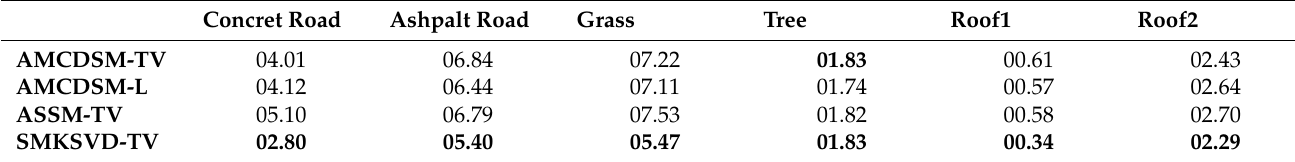
Table 11. HYDICE urban image: Commission errors of each class.